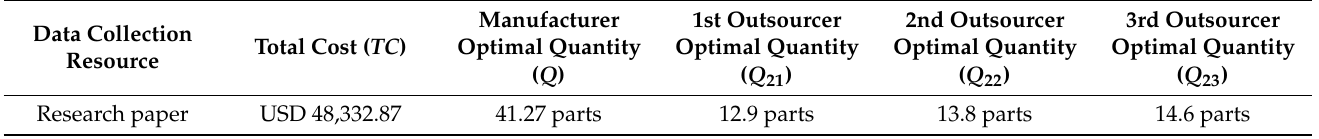
Table 4. Mathematical model outputs for different sources of